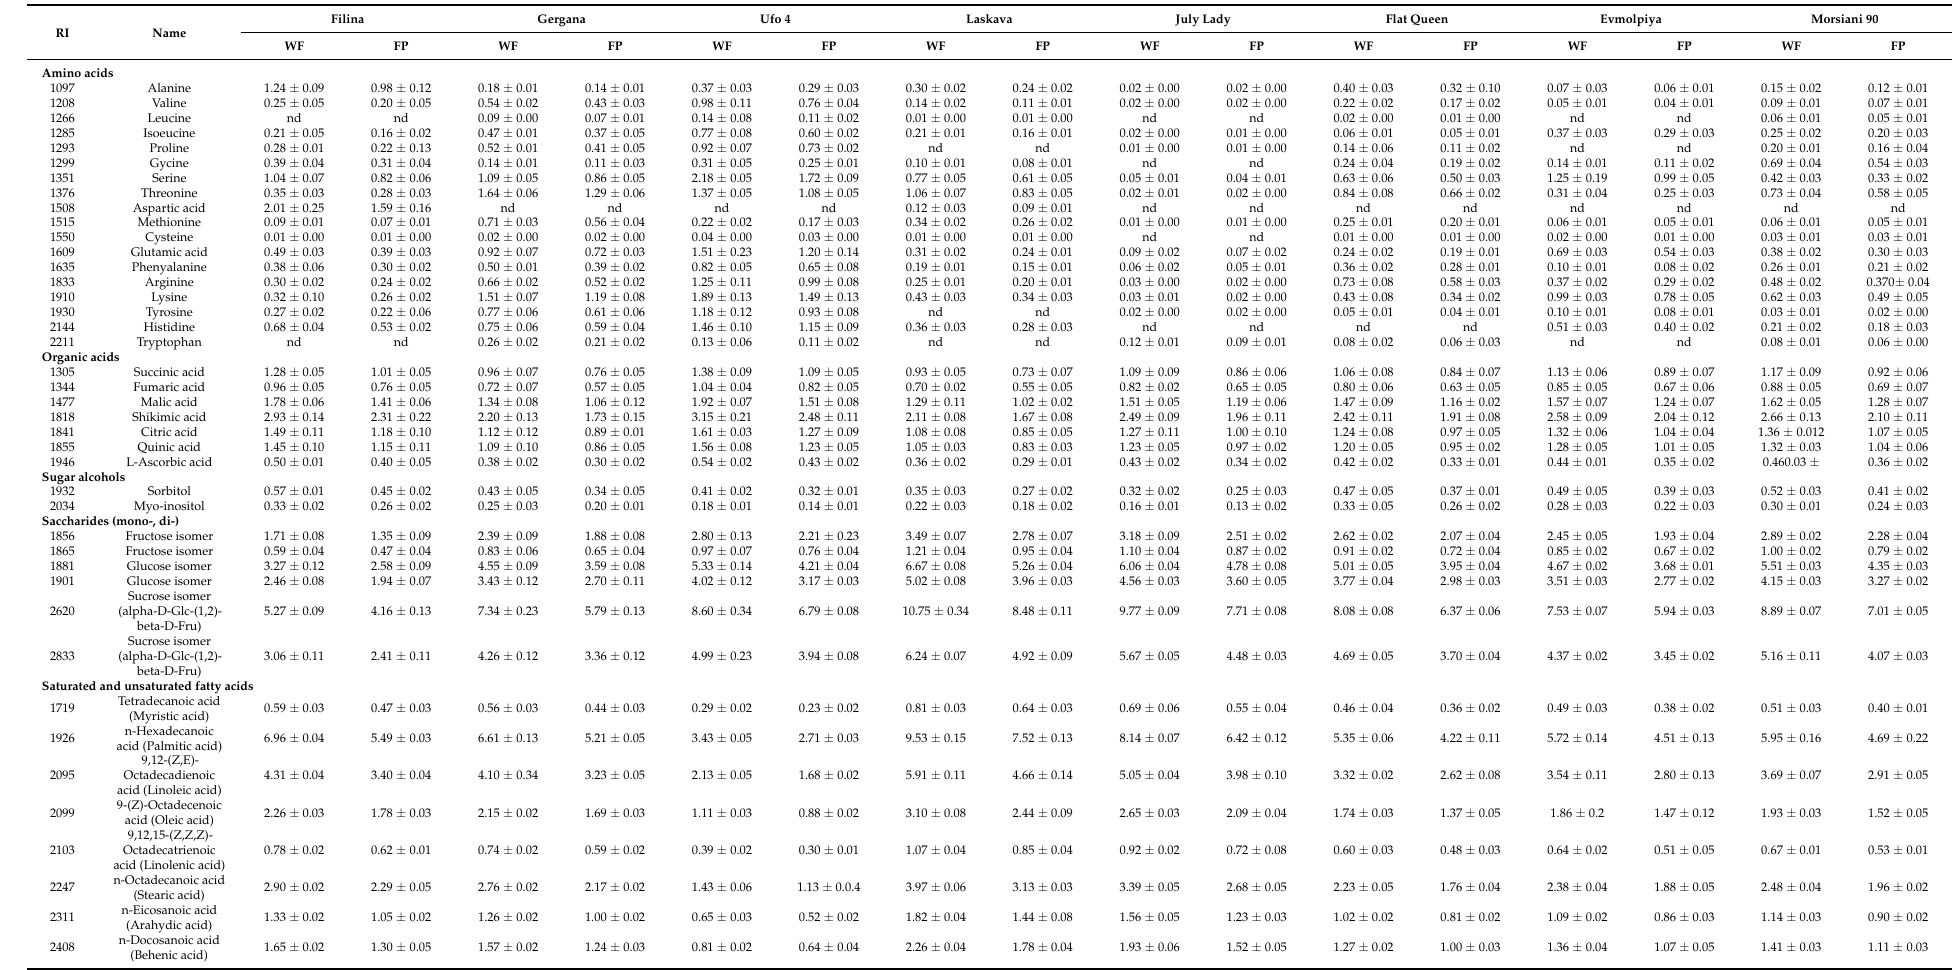
Table 1. Metabolites identified in peach fruit (WF) and pulp (FP) of 8 varieties analyzed by HS-SPME-GC-MS. The results are given in mg/g